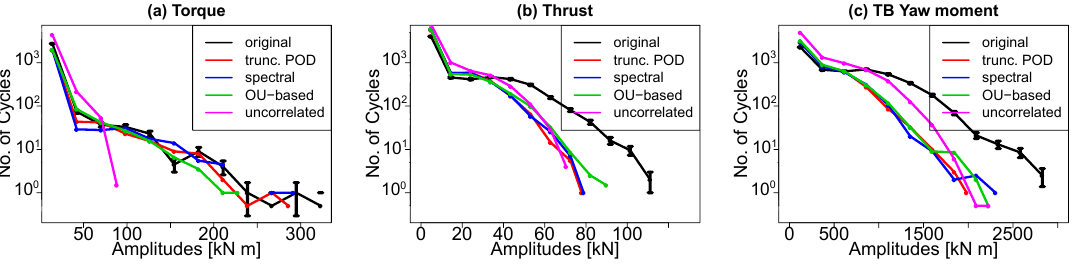
Figure 18. RFCs of the different loads for the original LES and the different wake descriptions using N = 6 POD modes. To get an impression of the estimation error, the standard error is shown for the √ n i original LES. It is estimated by where n i is the number of half-cycles in bin i . Note that we aim to 2 capture the behaviour of truncated PODs here, as pointed out in the beginning of this section.